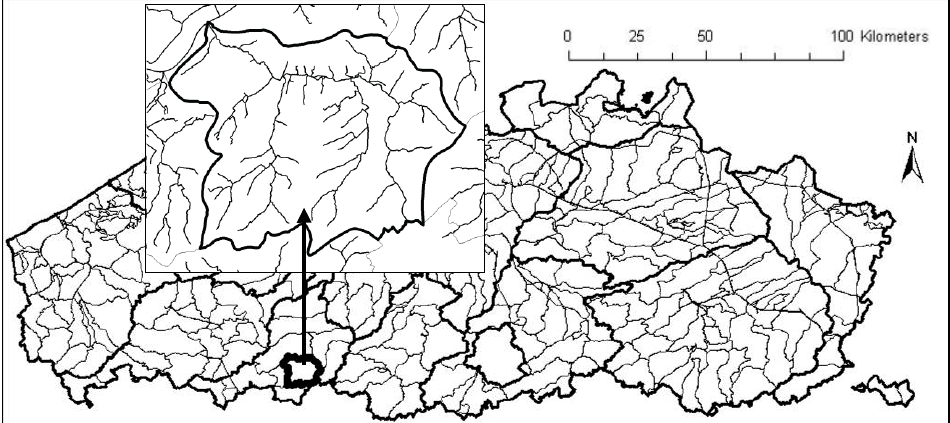
Fig. 2 Overview of the Flemish basins and catchments and detail of the Maarkebeek catchment.